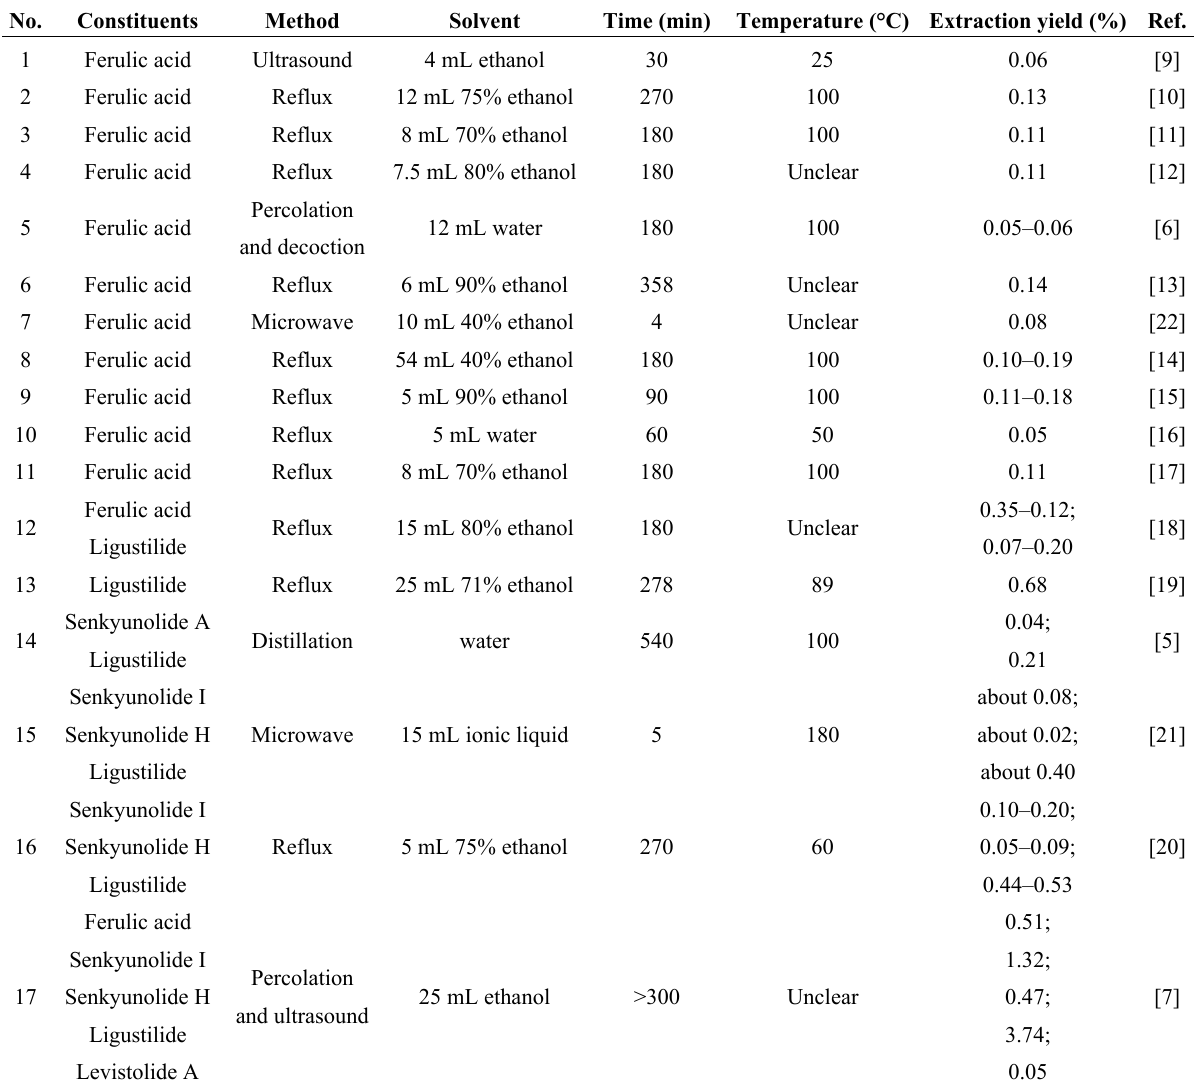
Table 1. Extraction conditions of different methods used for L. chuanxiong